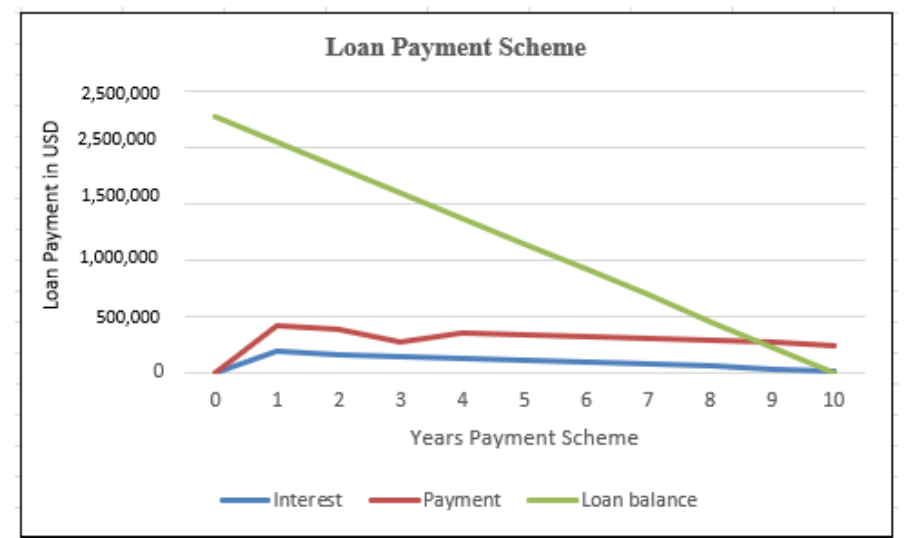
Figure 11. Loan payment illustration.